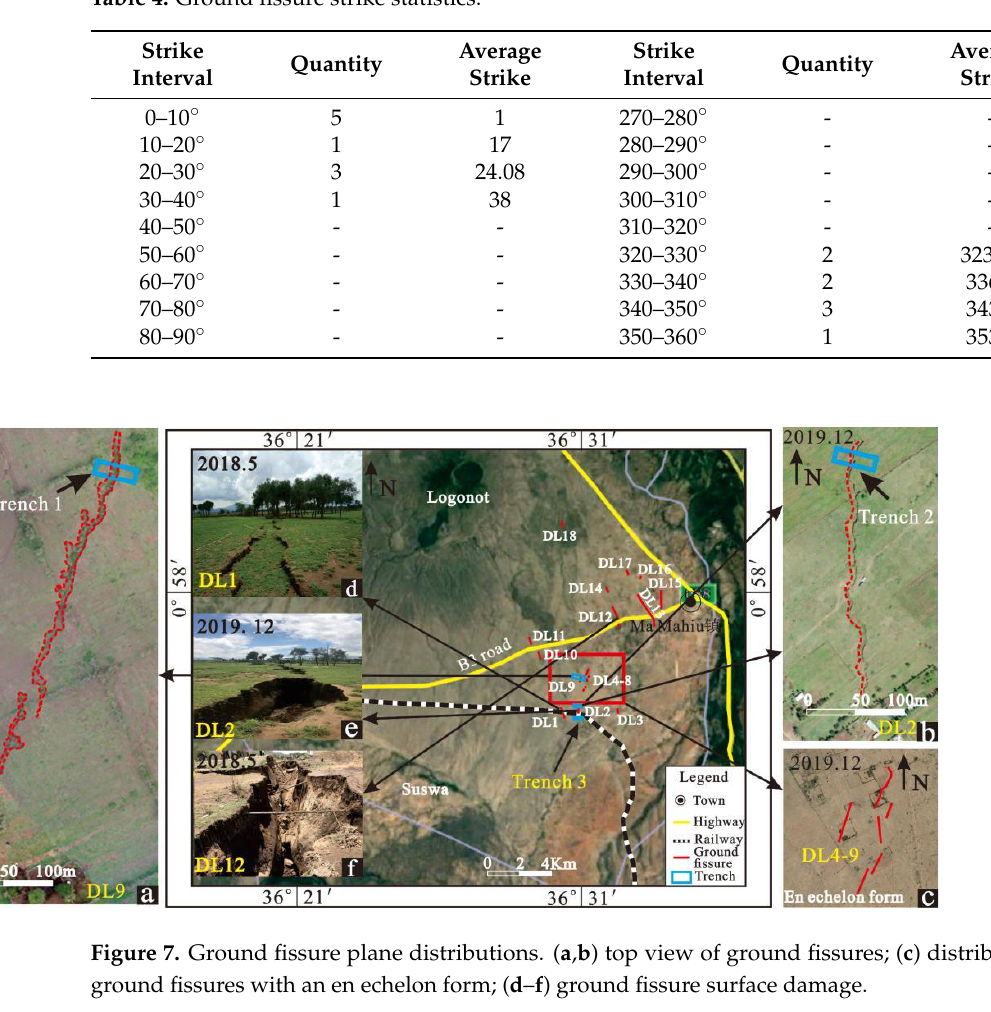
Table 4. Ground fissure strike statistics.